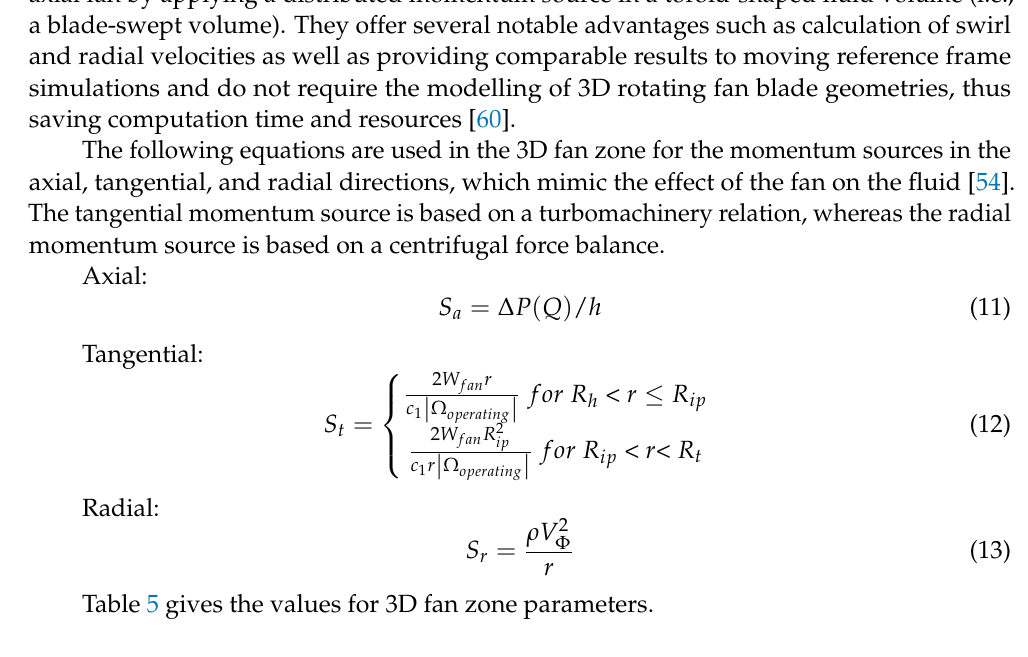
Table 5. Values for 3D fan zone